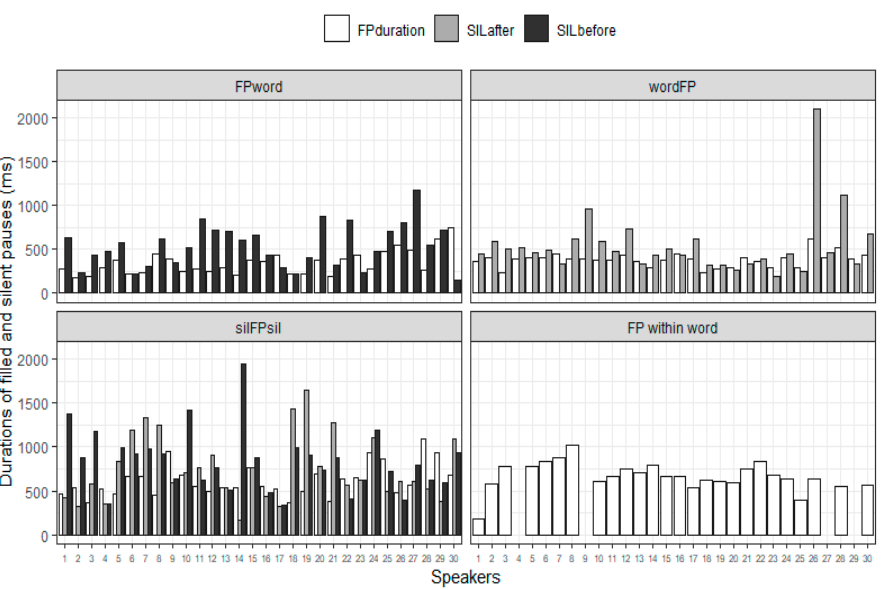
Figure 4. Durations of FPs and silent pauses according to the four FP positions analyzed for all the speakers. The white bars stand for the durations of FPs, grey bars stand for durations of silent pauses that follow FPs, while black bars stand for durations of silent pauses that precede